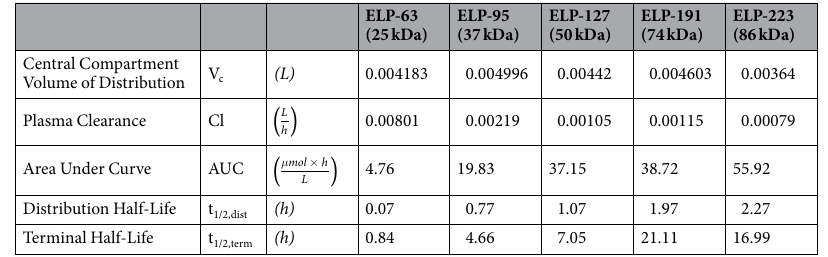
Table 3. Pharmacokinetics of ELP constructs in